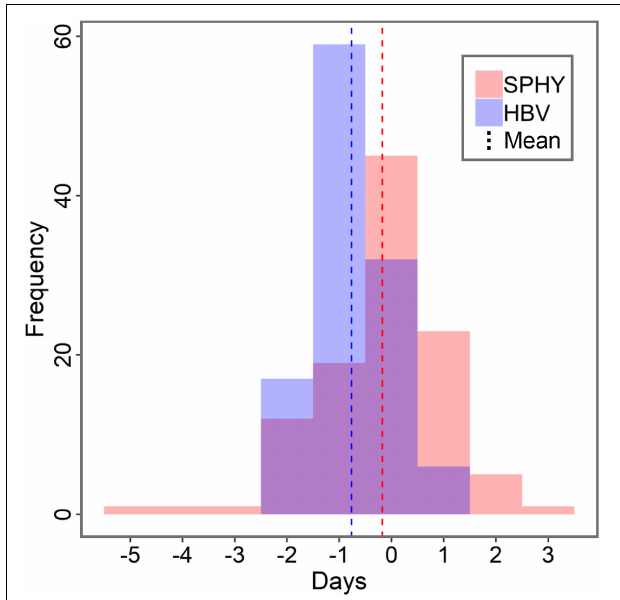
FIGURE 6 | The frequency plot for the peak of the floodwave models compared with the observation. The X axis represent the lag in the peak of the wave as compared to the observed peak. The negative and positive value represents the peak of the modeled waves are earlier and later than the peak of observed floodwaves. The dash line (blue and red) represent the weighted mean of the distribution (HBV and